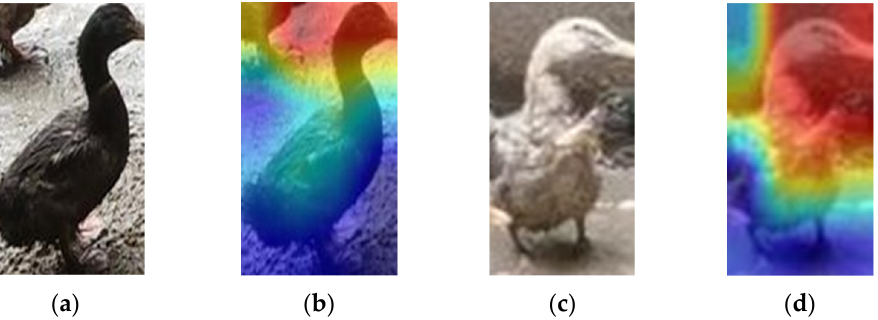
Figure 15. Heat map of VovNet_27slim. ( a , b ), respectively, show the original and heat map of the male duck; ( c , d ), respectively, show the original and heat map of the female duck. The redder the color, the more interested the computer is in the area, and the bluer the color, the less concerned it is. Grad-CAM shows that the network focuses on the heads of male and female